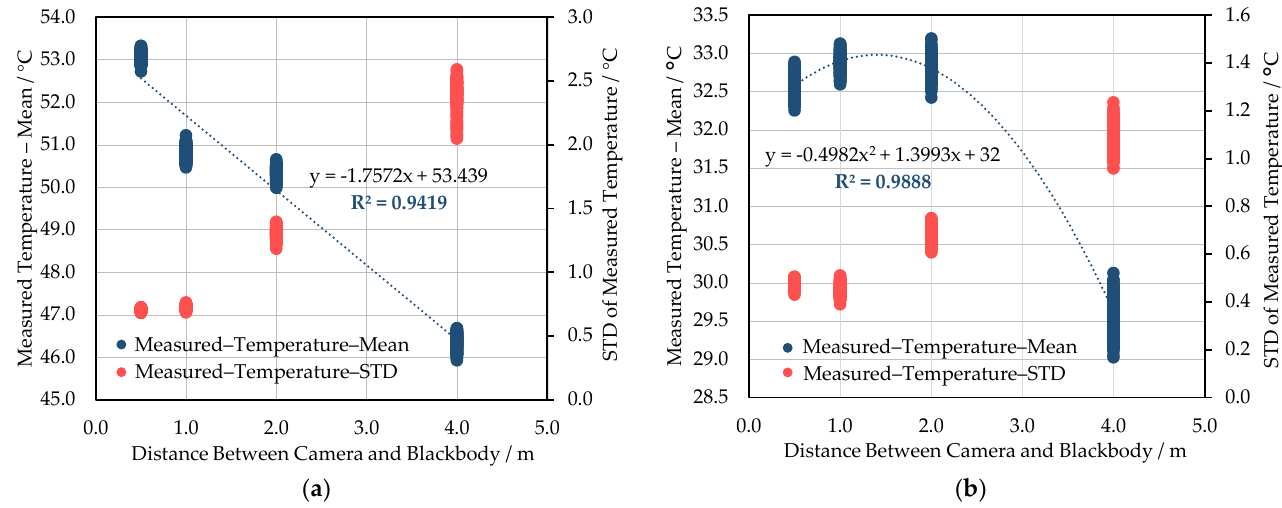
Figure 9. The correlation between the measured temperature by WIRIS and the measuring distance. These sessions were conducted at the blackbody temperature of 55 °C ( a ) and 35 °C ( b ). The STD of temperature observation is also included in the charts above.